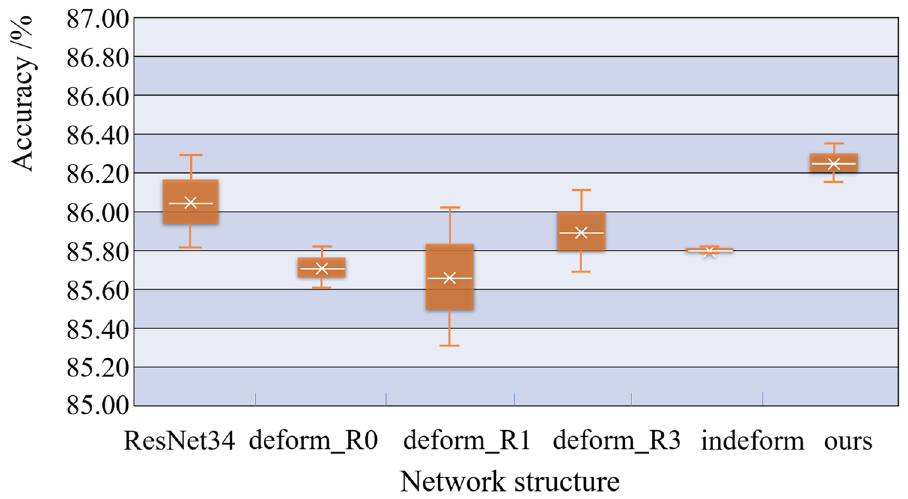
Figure 14. Classification accuracy of engine sounds by different network structures.